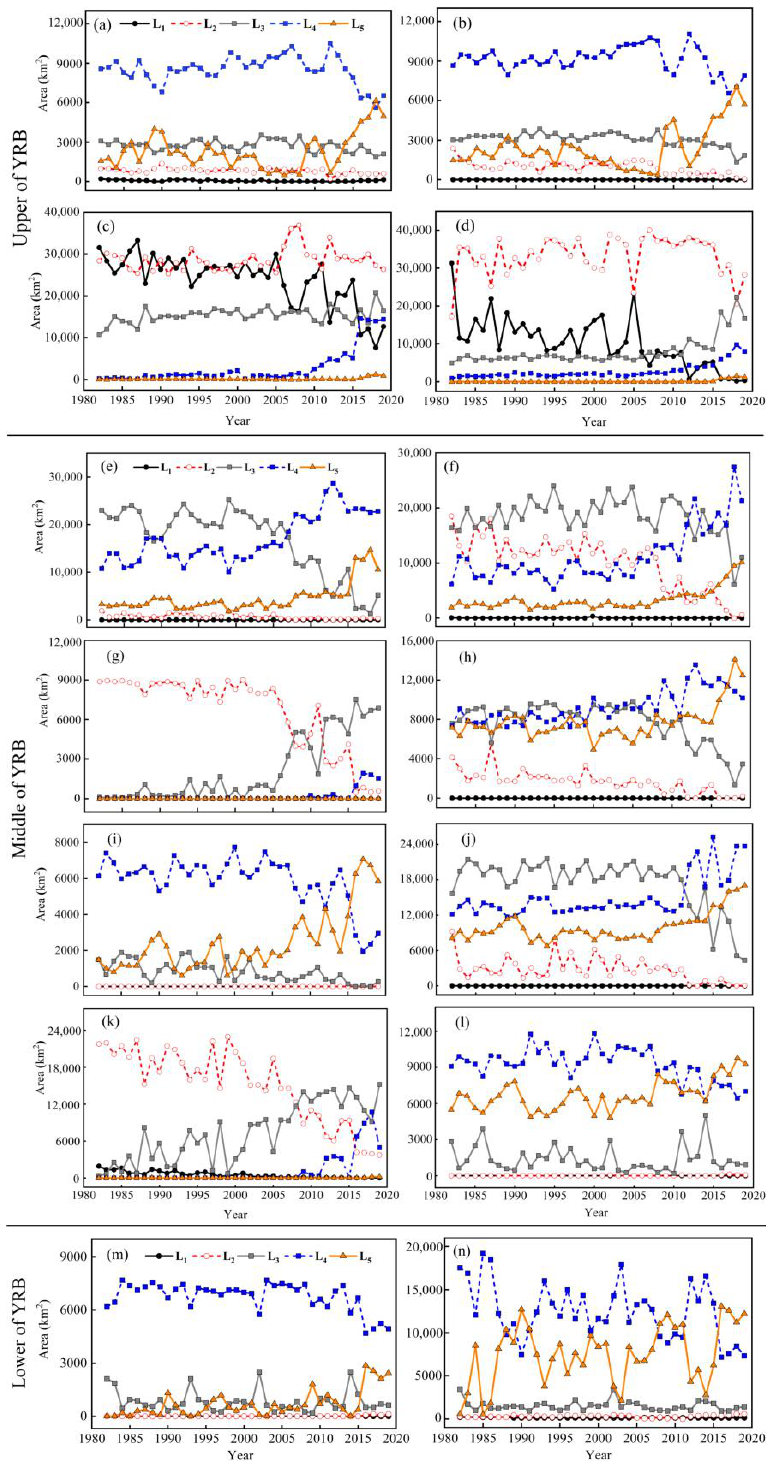
Figure 7. Temporal variation in the normal difference vegetation index (NDVI) at all levels in the sub-basins of the Yellow River Basin (YRB). L 1 – L 5 represent the NDVI levels of <0.2, 0.2 – 0.4, 0.4 – 0.6, 0.6 – 0.8, and >0.8, respectively. ( a – d ) represent Datong, Huangshui, Shizuishan-Toudaoguai, and Xiaheyan-Shizuishan in the Upper Yellow River Basin, respectively; ( e – l ) represent Fen, Jing, Kuye, Beiluo, Qin, Wei, Wuding, and Yiluo in the Middle Yellow River Basin, respectively; and ( m , n ) represent Gaocun-Lijin and Upper daicunba, respectively.